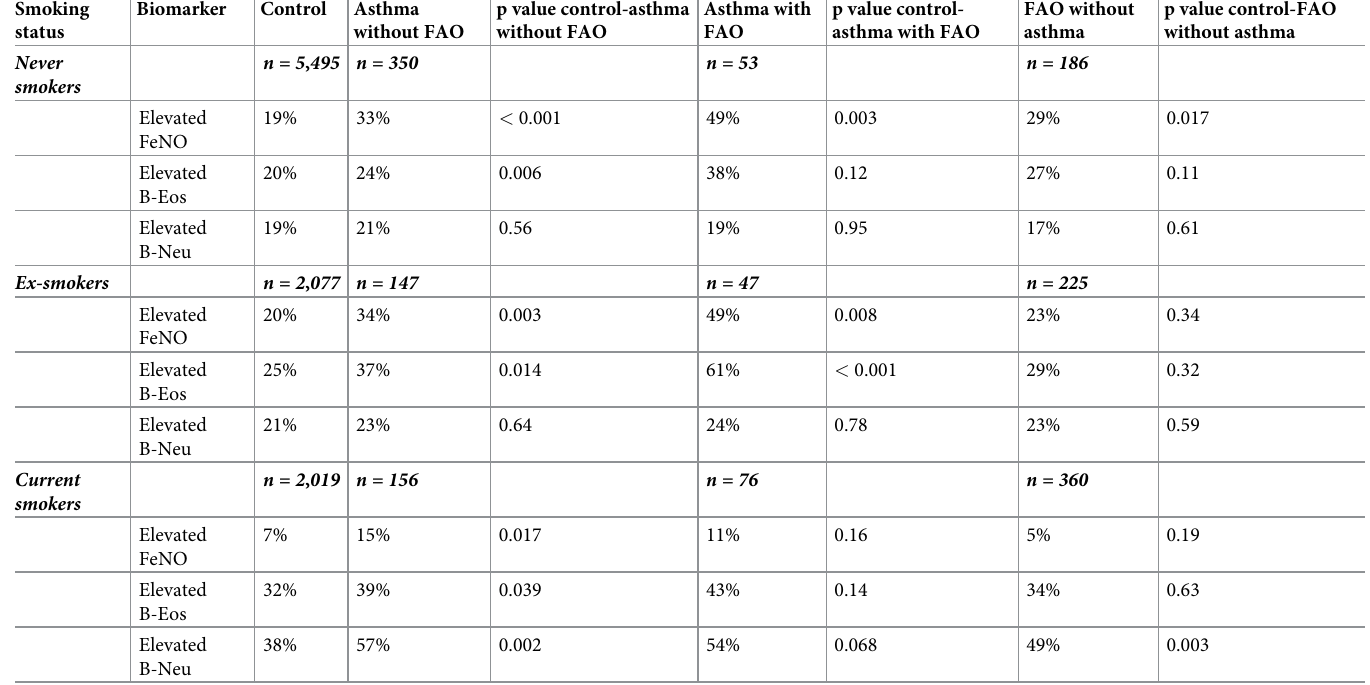
Table 2. Percent with elevated markers (FeNO � 25ppb, B-Eos � 300 cells/ μ L, B-Neu � 5100 cells/ μ L) in the asthma and FAO groups compared with the control group, stratified by smoking status. Smoking status